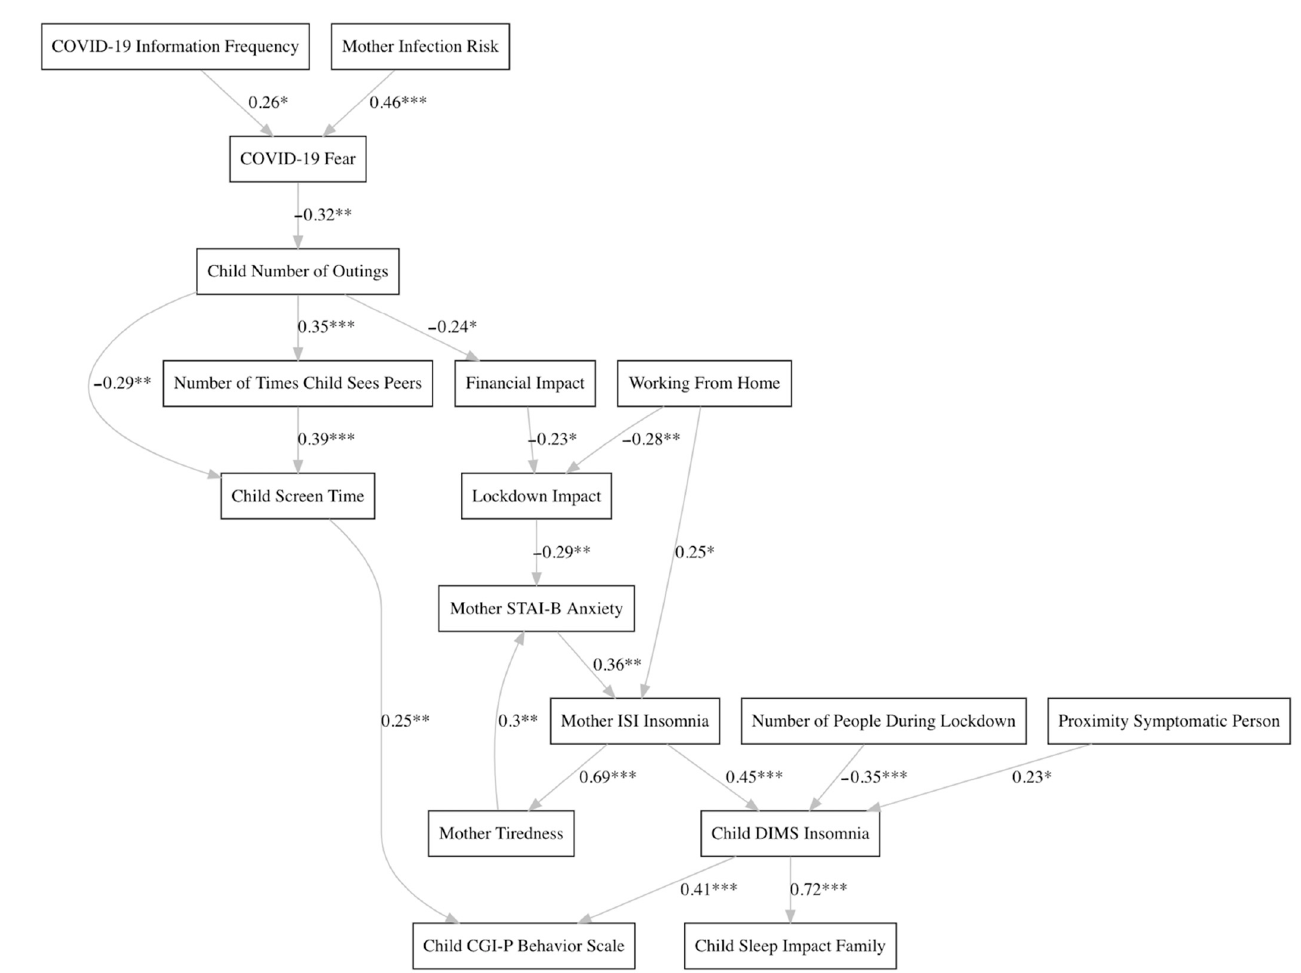
Figure 3. Path analysis for the French sample using the structural equation modeling framework. The principal network structure was derived through a data-driven, Bayesian network structure learning approach. Significance levels of the relationships modeled: *** p < 0.001, ** p < 0.01, and * p < 0.05.